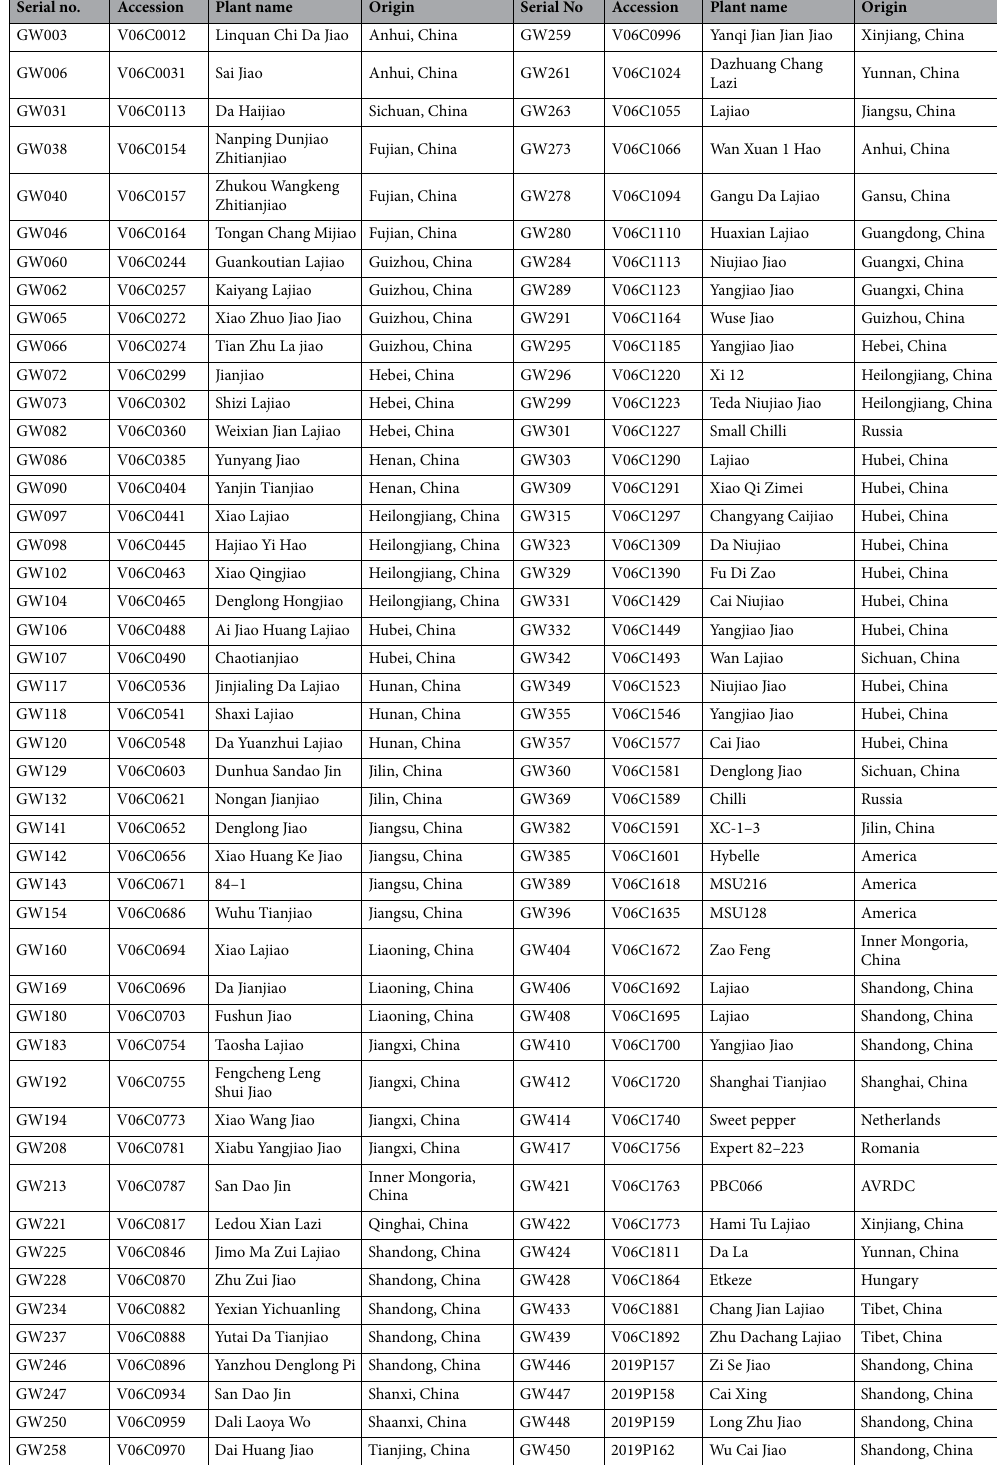
Table 1. The accession number, variety name and origin of the 94 local landraces used in the